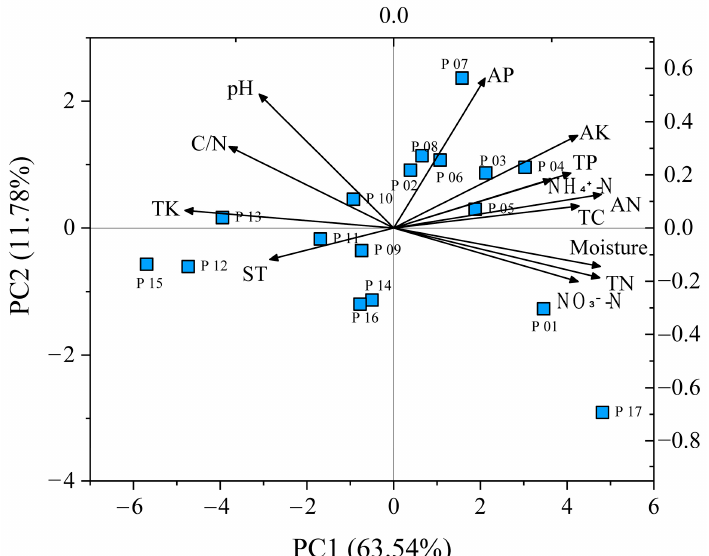
Figure 3. Principal component analysis (PCA) of soil properties in different D. angustifolia populations. Gray arrows indicate environmental factors, the red squares indicate D. angustifolia sampling